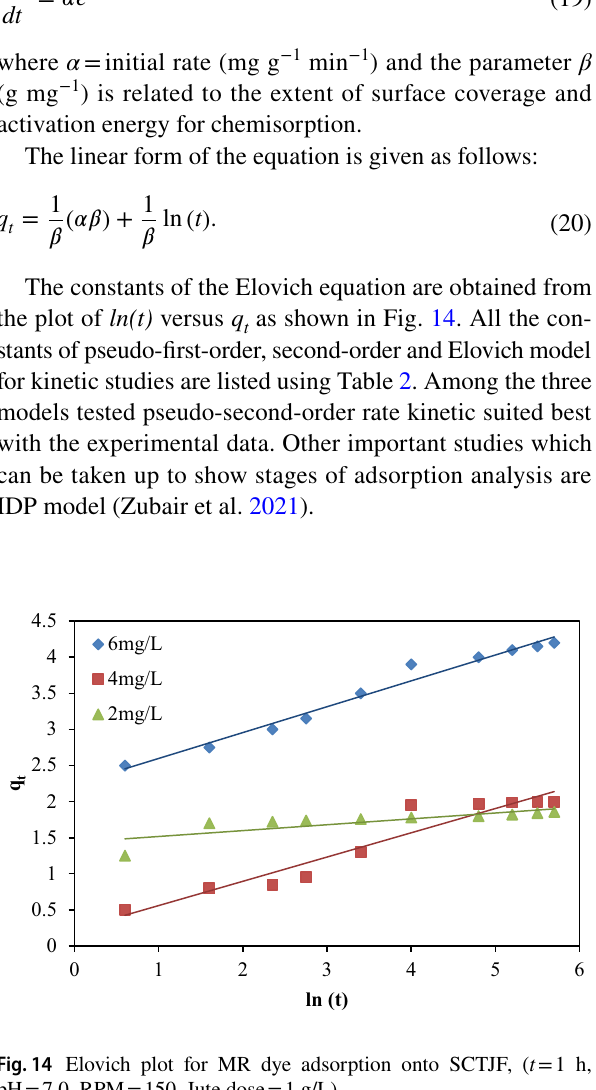
Fig. 14 Elovich plot for MR dye adsorption onto SCTJF, ( t = 1 h, pH = 7.0, RPM = 150, Jute dose = 1 g/L)